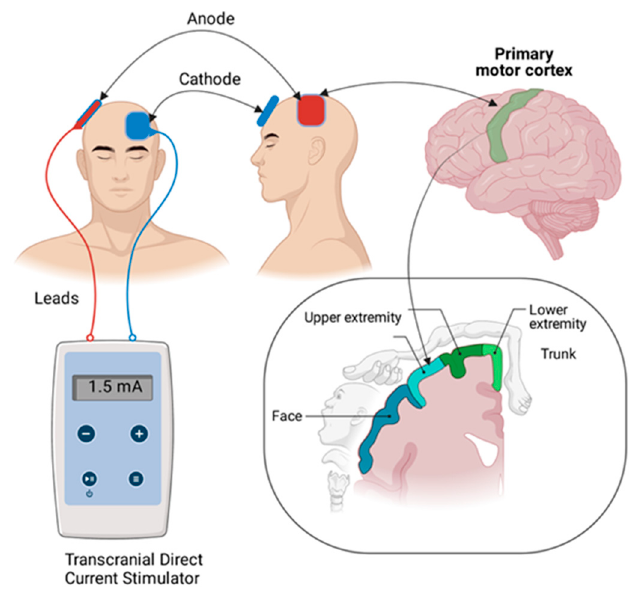
Figure 2. Placement of electrodes and corresponding cortical area of tDCS simulation.